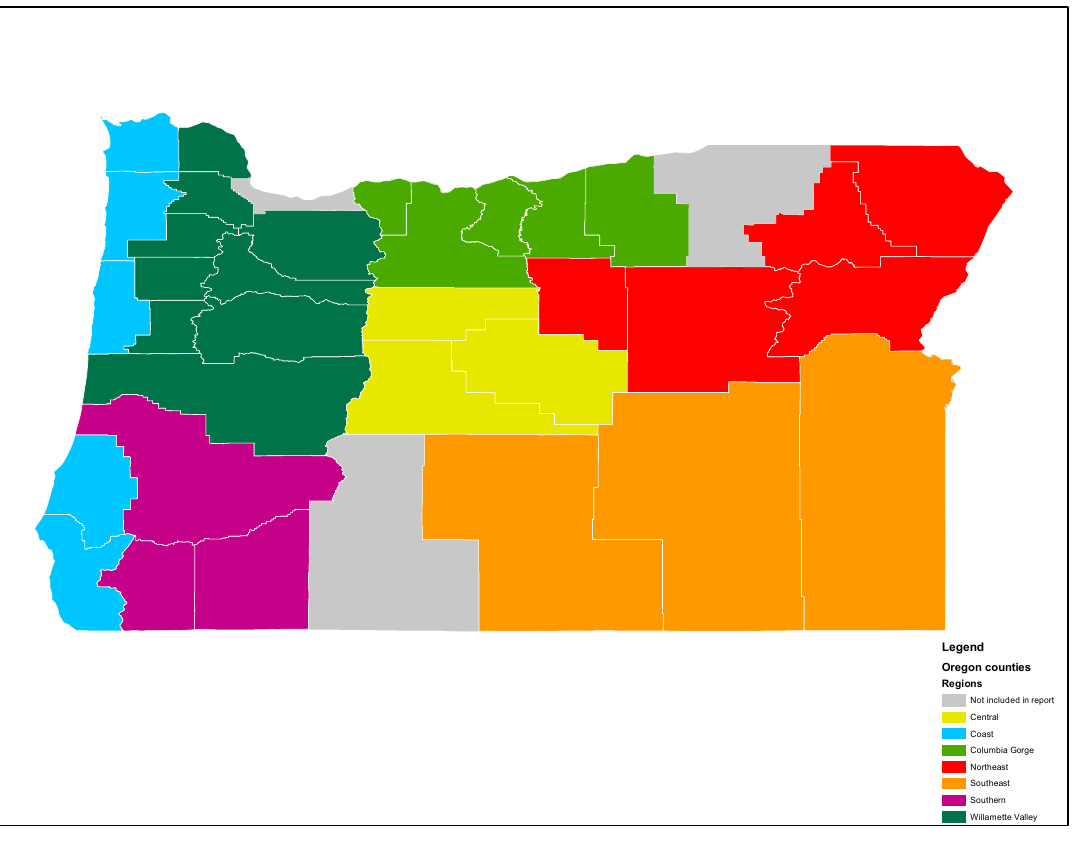
Figure 2. Seven agricultural regions of Oregon